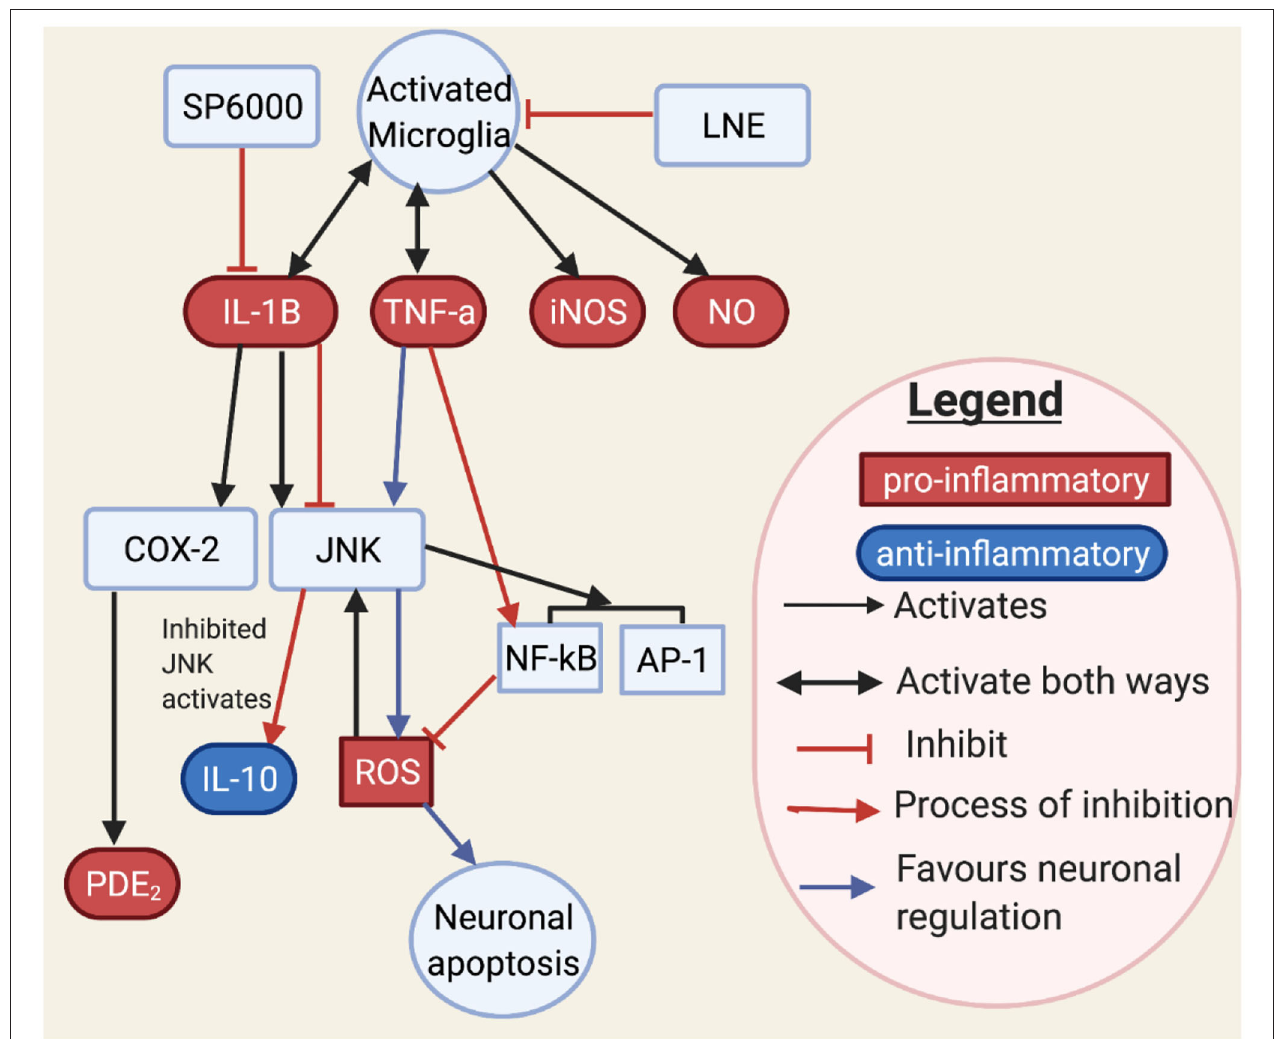
FIGURE 7 | This figure shows how JNK may interact with neurons and microglia through cytokines and transcription factors. JNK controls inflammatory mediators such as IL-1B, TNF- α , iNOS, and NO ( 126–128). Activated JNK has been involved with cytokine, oxidative species, and transcription factors. TNF- α stimulates JNK, which in turn stimulates ROS. However, ROS may in turn stimulate JNK. It is known that TNF- α stimulating JNK would result in neuronal apoptosis. Moreover, NF-kB when stimulated by TNF would inhibit ROS ( 127). An aromatic herb, lindera neesiana kurz (LNE), used as an anti-inflammatory substance, reduces pro-inflammatory expression in LPS stimulated microglia cells, such as JNK, p-38, NO, iNOS, COX-2 production and pro-inflammatory cytokine related neuronal injury to JNK phosphorylation in microglia cells (116, 129) and suggested that JNK activation, triggers pro-inflammatory mediators such as TNF- α , IL-6, IL-1 β , COX-2, iNOS, NO and PGE 2 , and transcription factors such as AP-1 and NF- κ B. SP600125 is a JNK inhibitor which inhibits COX-2 activity through IL-1B. Conversely, IL-1B induces both COX-2 and JNK activation (126). This makes IL-1B a main target for JNK. JNK inhibition has also been observed to increase anti-inflammatory markers (116), which may restore the inflammatory imbalance observed in flush response and prevent microglial activated neuronal death (130).